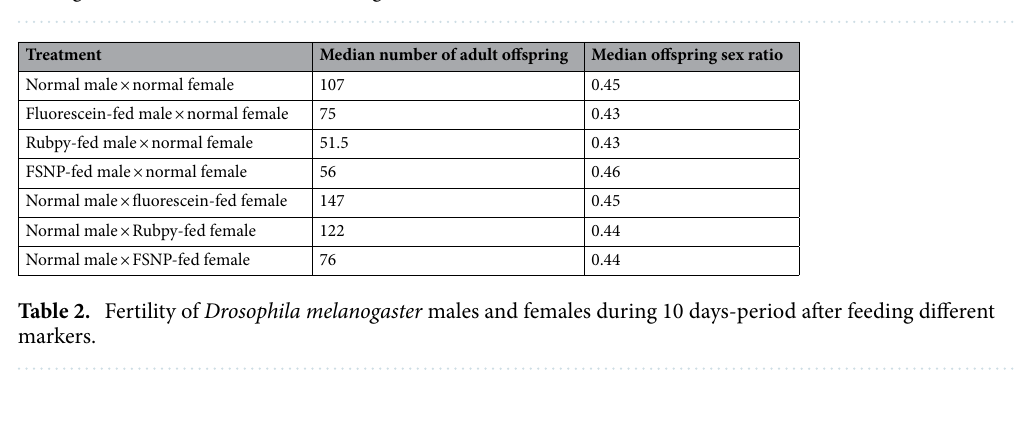
Figure 6. ( a ) Survival curves of Drosophila melanogaster fed with liquid food containing different markers and ( b ) lifespans of the fruit fly in each treatment. The horizontal lines within each box indicate the median, the box edges indicate the 75th and 25th percentiles, the whiskers show the maximum and minimum, and the circles represent outliers. Treatments with a common letter are not significantly different from each other as revealed by the aligned rank test at the 5% level of significance.